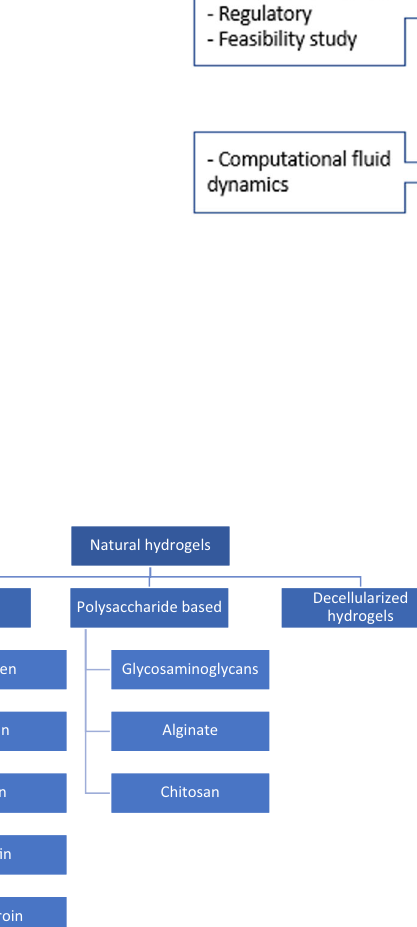
Fig. 2 Natural hydrogels materials classi fi cation [102]